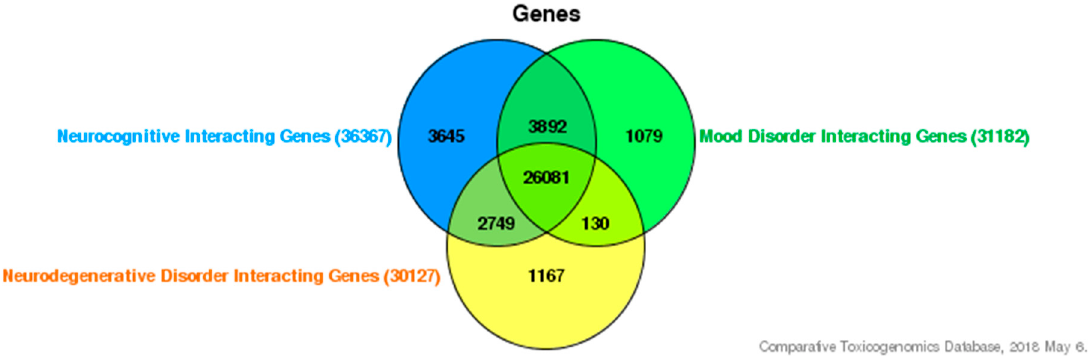
Figure 1. Interacting genes of neurocognitive categories. Shown are 26,081 genes that interact within the three categories.